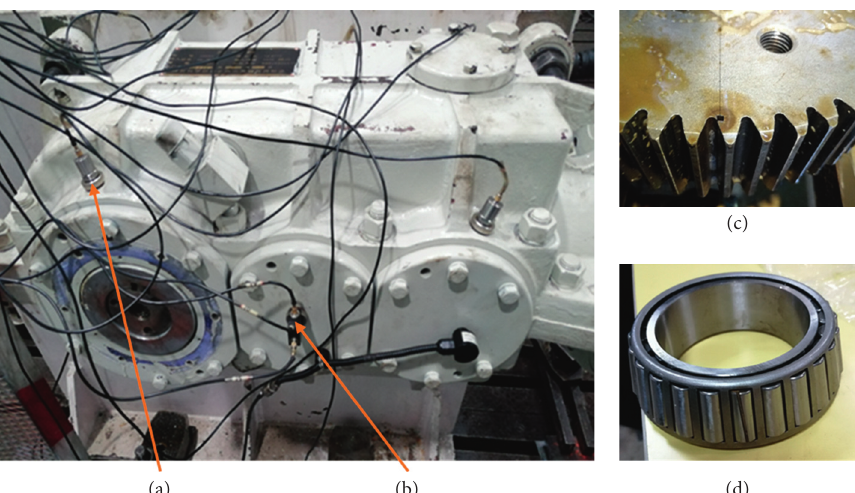
Figure 3: Gear box of the gyratory crusher and fault setting: (a) vibration signal acquisition sensor, (b) speed/acceleration sensor, (c) gear failure, and (d) rolling bearing failure.